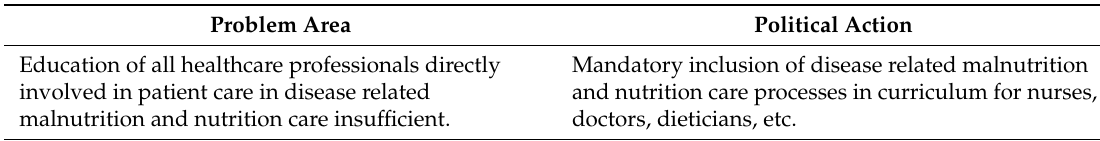
Table 5. Problem areas and suggested options for political